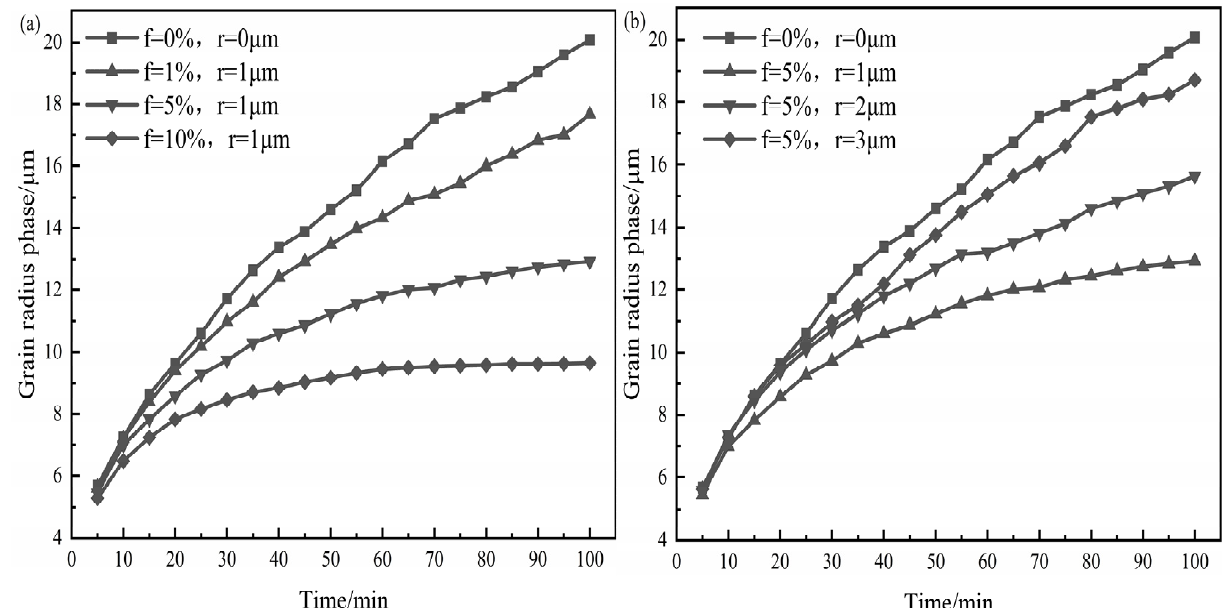
Figure 6. Curves of the change in the average grain size as a function of annealing time: ( a ) various volume fractions of SPP and ( b ) various sizes of SPP.